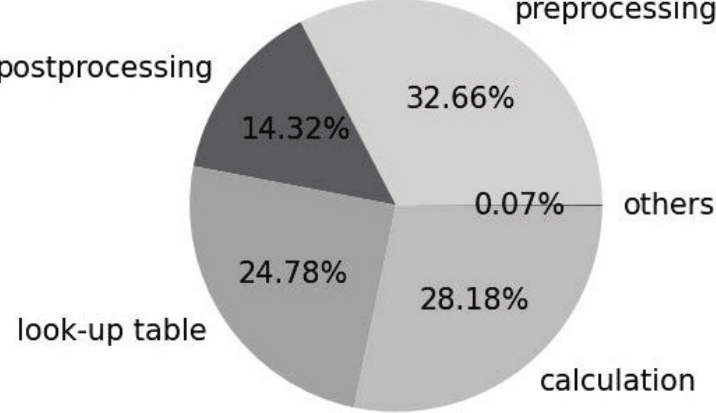
Figure 13. The area ratio of each module.